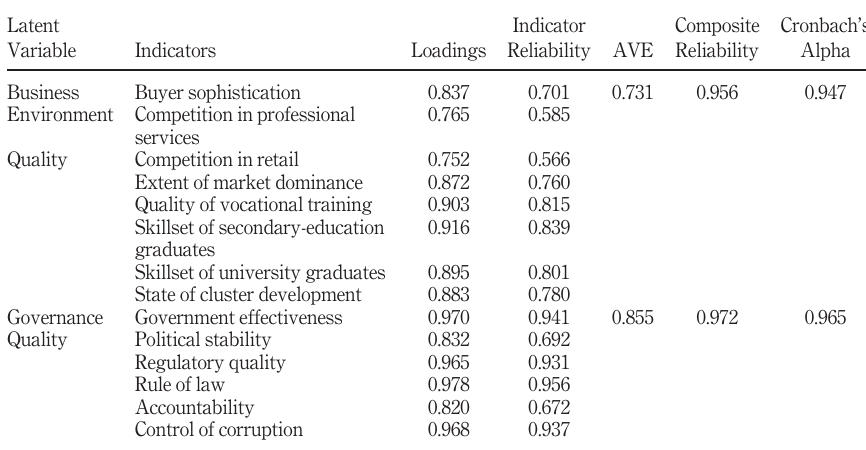
Table 4. Results summary